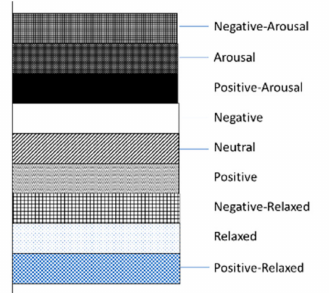
Figure 3. Emotional labels represented in each bar chart.